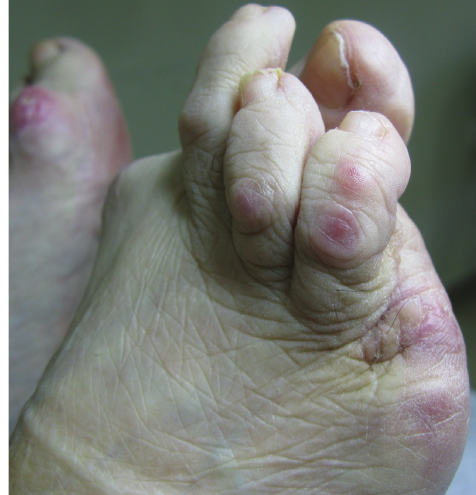
Figure 2: Postoperative photo of the right foot. The lesion has been excised on healthy boundaries with removal of the fifth